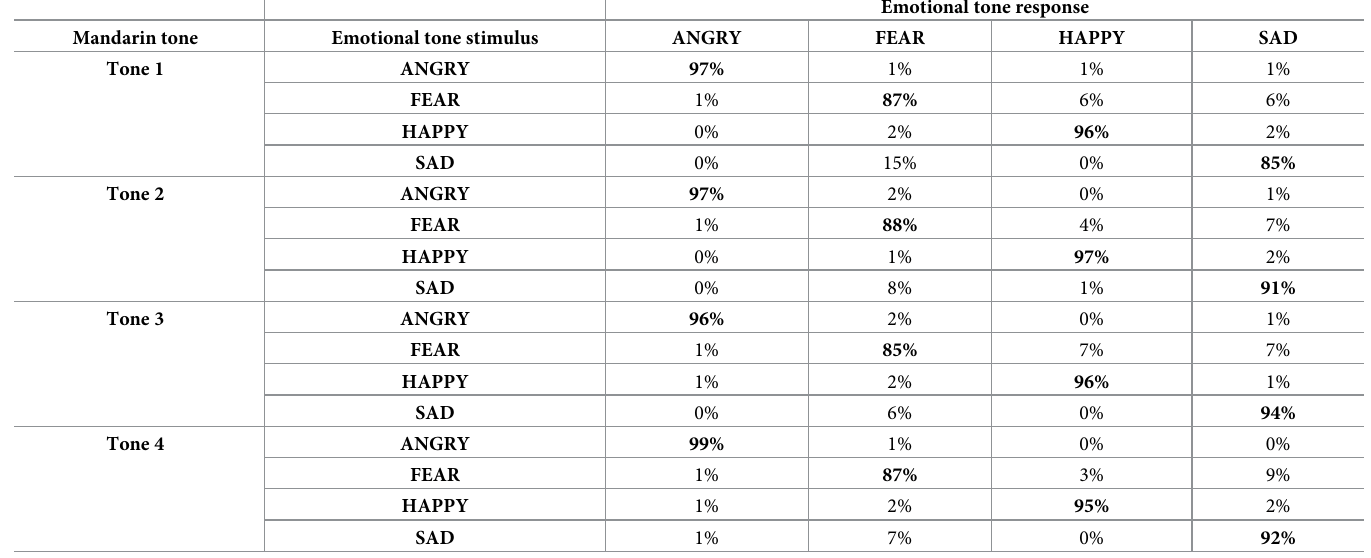
Table 8. Confusion matrices of emotion recognition responses for syllables presented in